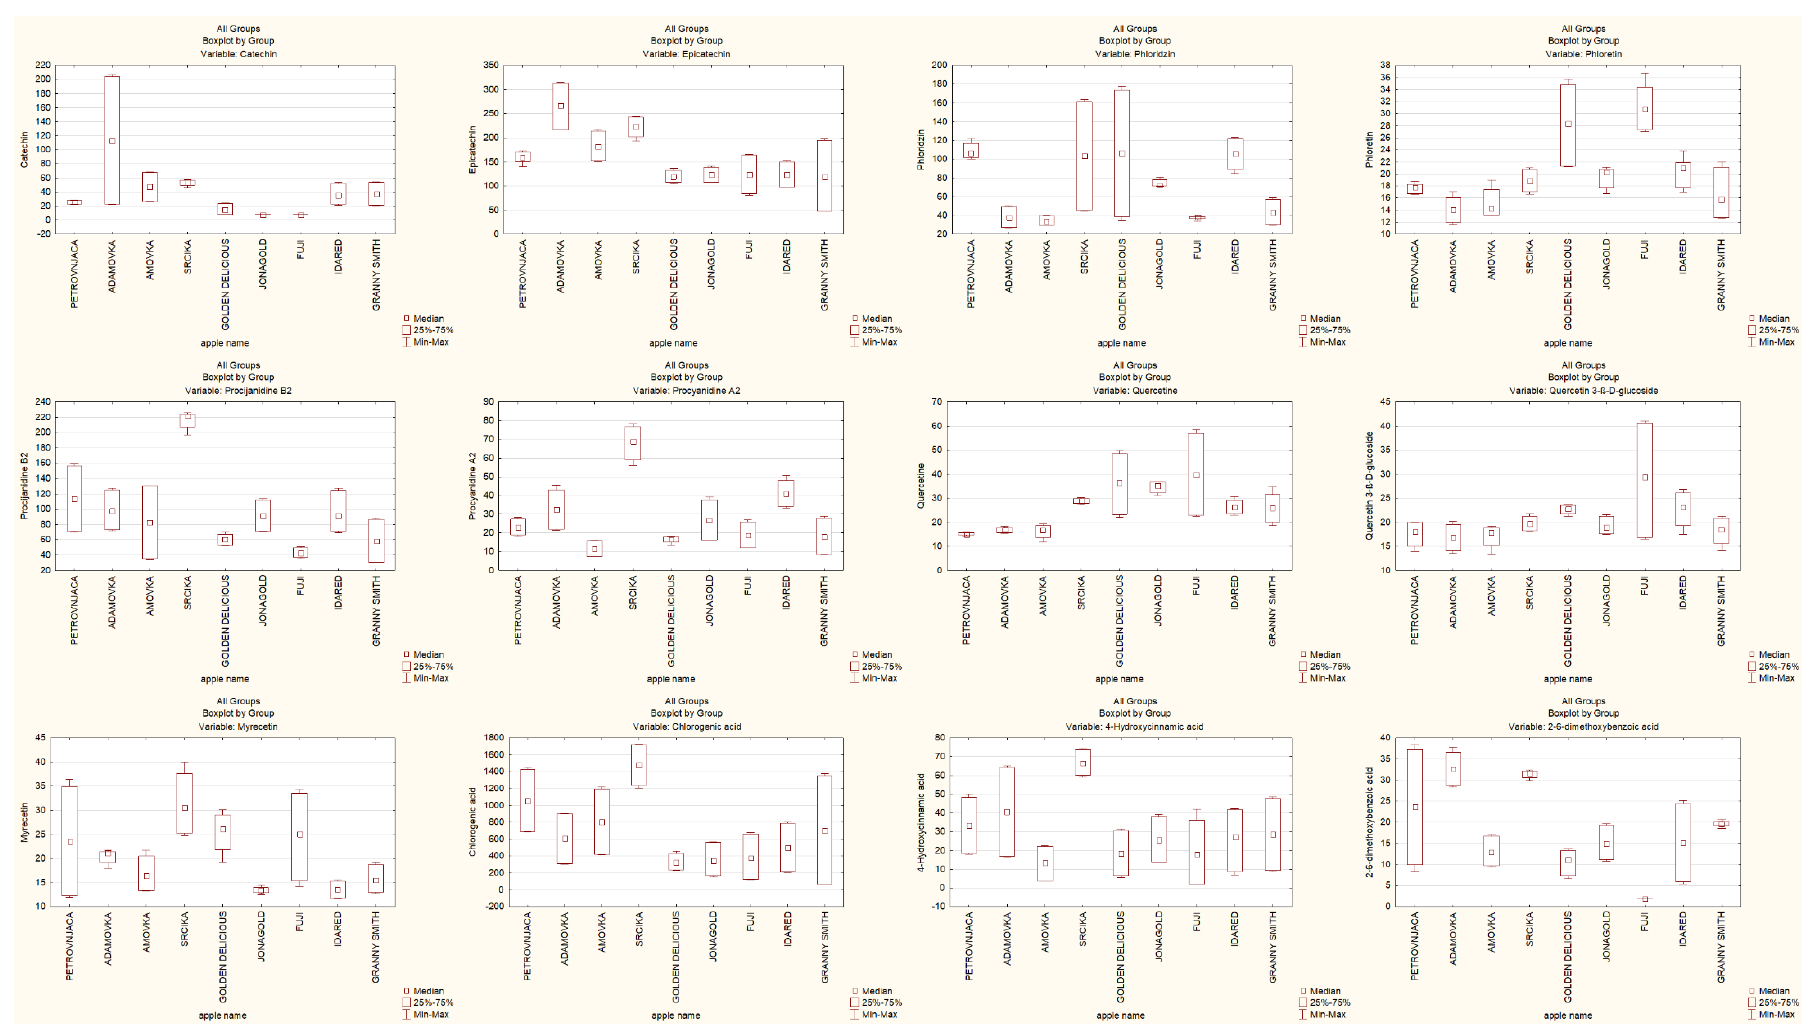
Figure 1. The content and ratio of identified polyphenols and patulin in traditional and conventional apple cultivars.